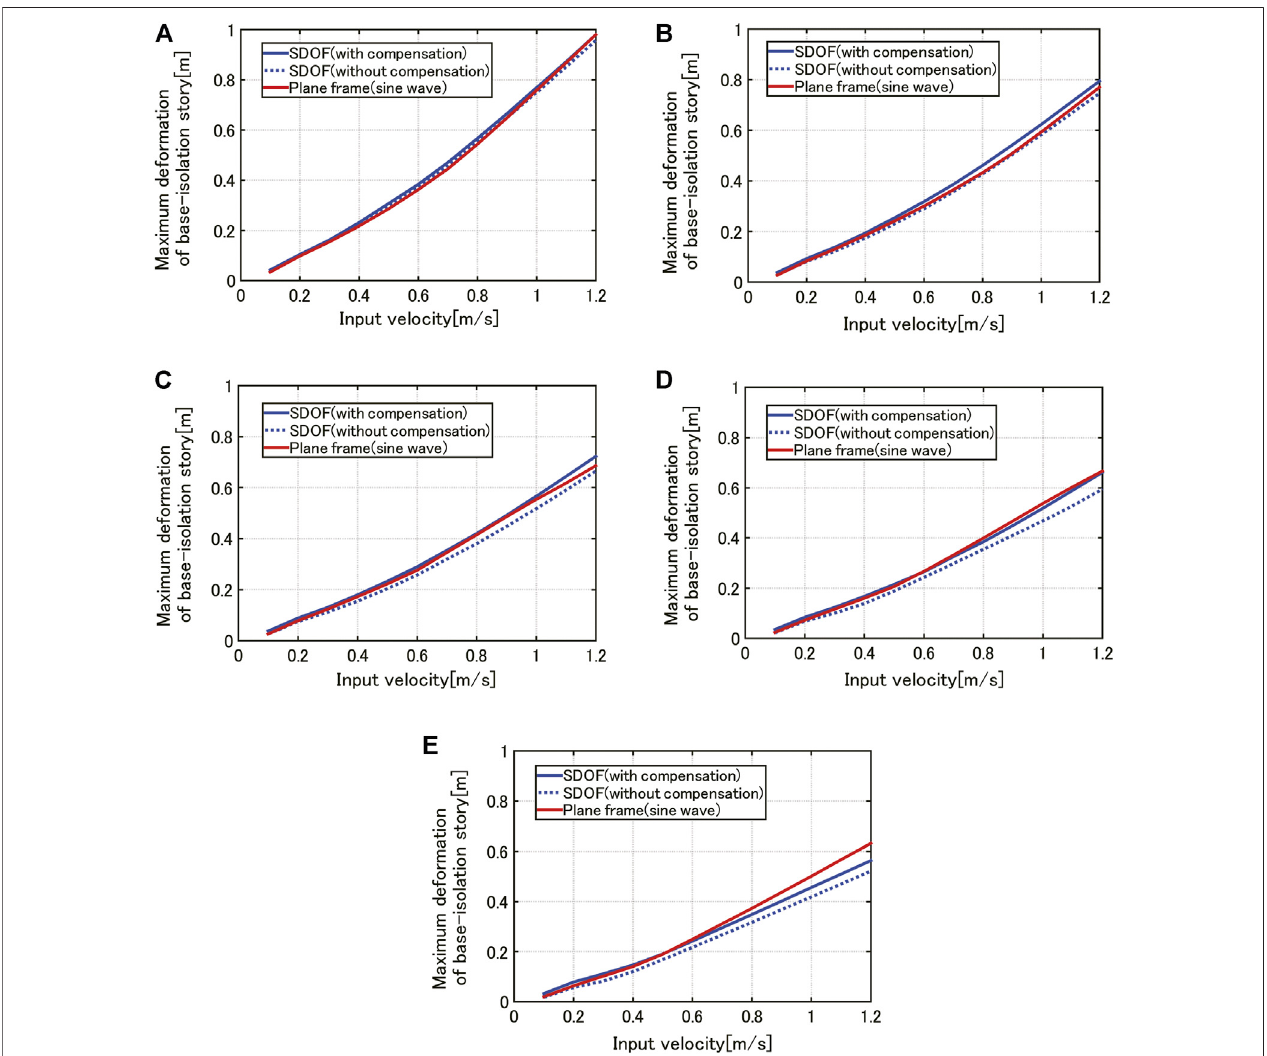
FIGURE 10 | Comparison of the maximum deformation of the base-isolation story by the proposed method for the SDOF model (with and without compensation factor) with that bytime-history responseanalysis for the plane frame model for various connection damper levels, (A) c (cid:2) 0.208 [kN/(mm/s)], (B) c (cid:2) 0.417 [kN/(mm/s)], (C) c (cid:2) 0.521 [kN/(mm/s)], (D) c (cid:2) 0.625 [kN/(mm/s)], (E) c (cid:2) 0.833 [kN/(mm/s)].